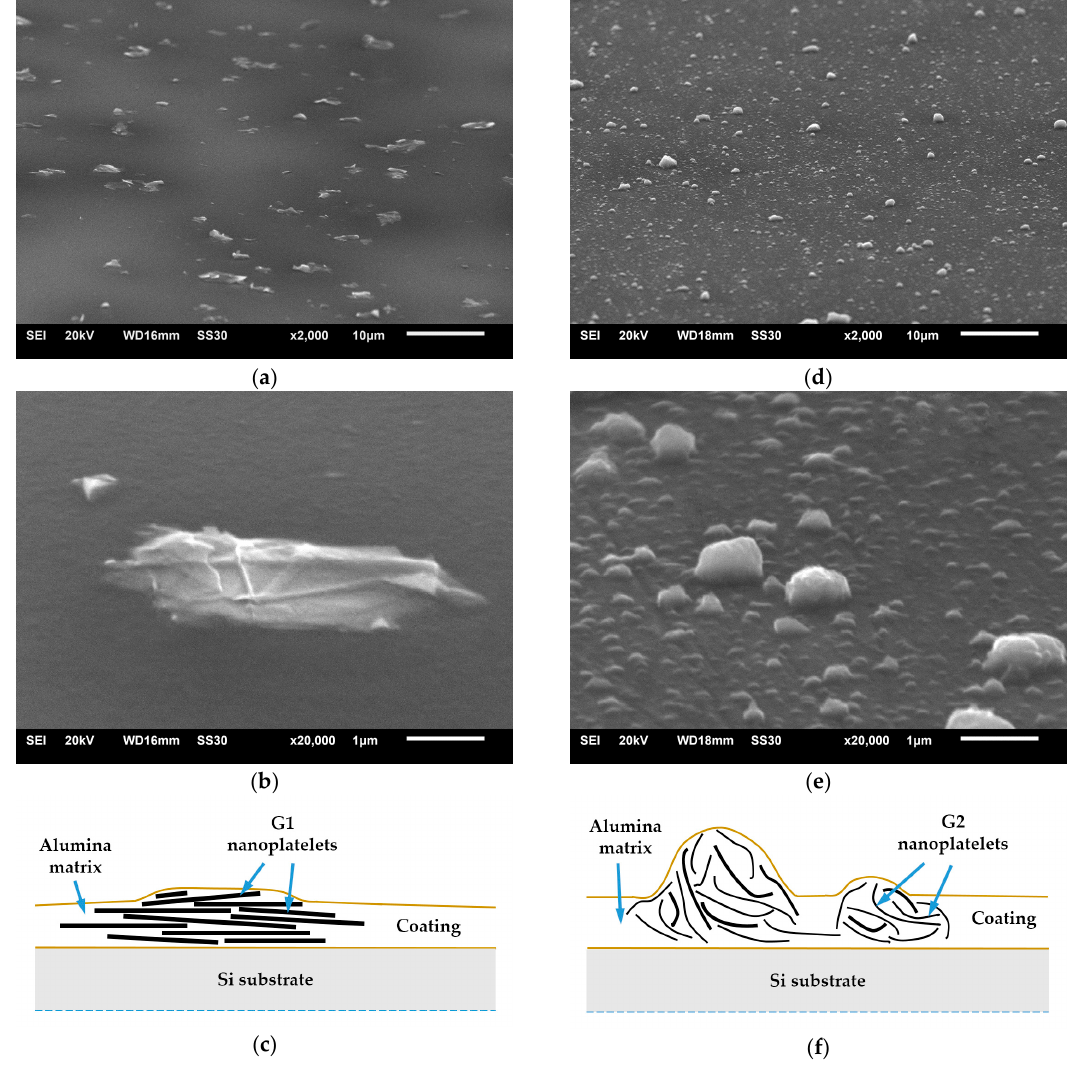
Figure 2. SEM images of Al 2 O 3 + graphene coatings with 1% of graphene in sol suspension: ( a , b ) Al 2 O 3 + G1 coatings; ( d , e ) Al 2 O 3 + G2 coatings, and proposed schemes of their internal structures ( c , f ).